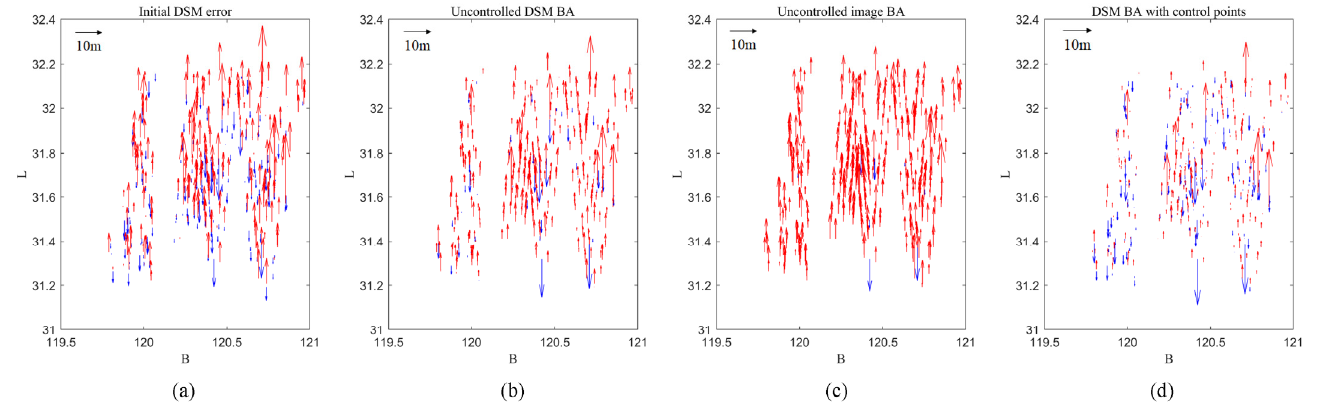
Figure 5. Elevation error distribution on check points for the ZY-3 DSMs (positive errors are indicated by the up-pointing red arrows and negative errors by down-pointing blue arrows). ( a ) before block adjustment, ( b ) uncontrolled DSM block adjustment, ( c ) uncontrolled images block adjustment. ( d ) controlled block adjustment.